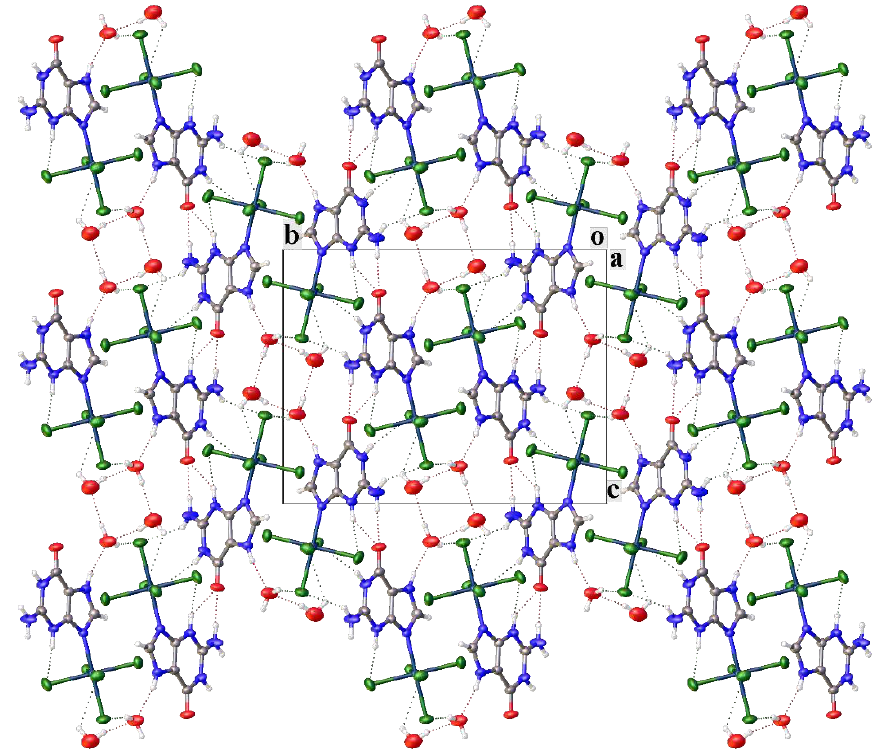
Figure 4. Packing diagram of 2 , view along the [100] direction. 0 indicates the origin of the unit cell and a, b, c — lattice translations.